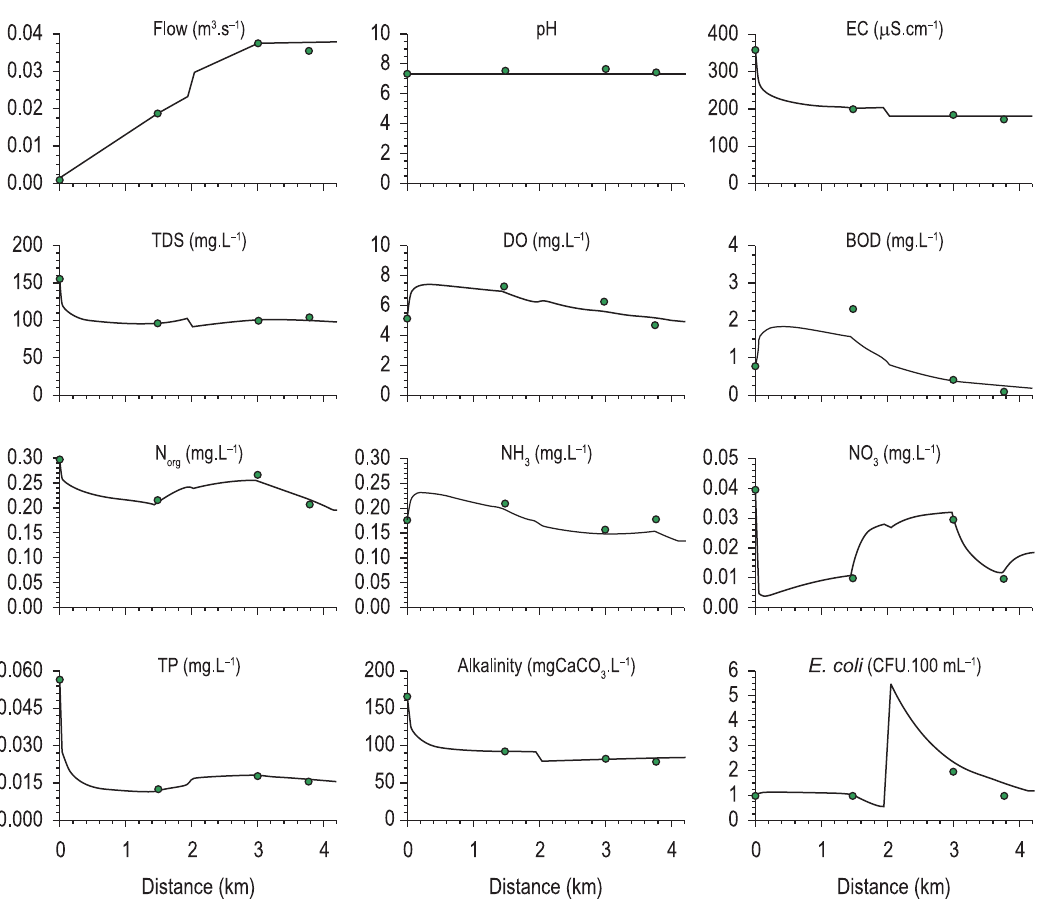
Figure 7. Model validation for the water quality parameters in the Fidalgo Stream using the dry season